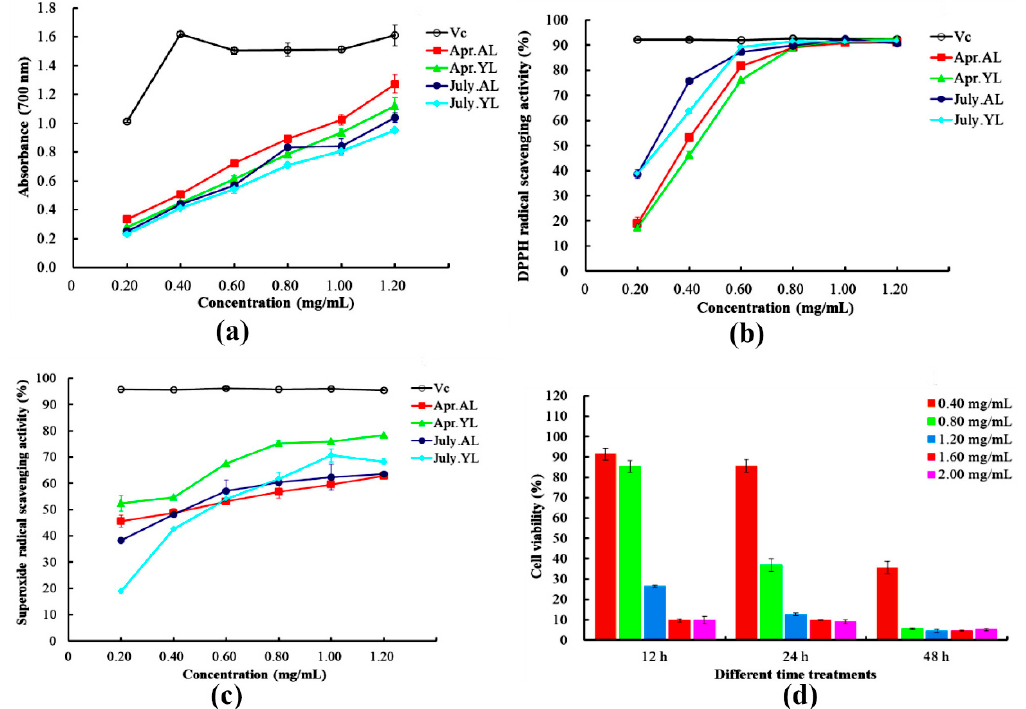
Figure 4. Antioxidant and anticancer activities of samples with different concentrations (mg of RE/mL of flavonoids extract). ( a ) Ruding power; ( b ) DPPH radical scavenging activity; ( c ) Superoxide radical scavenging activity; ( d ) Time dependent dose-response of HeLa cells determined with CCK-8.